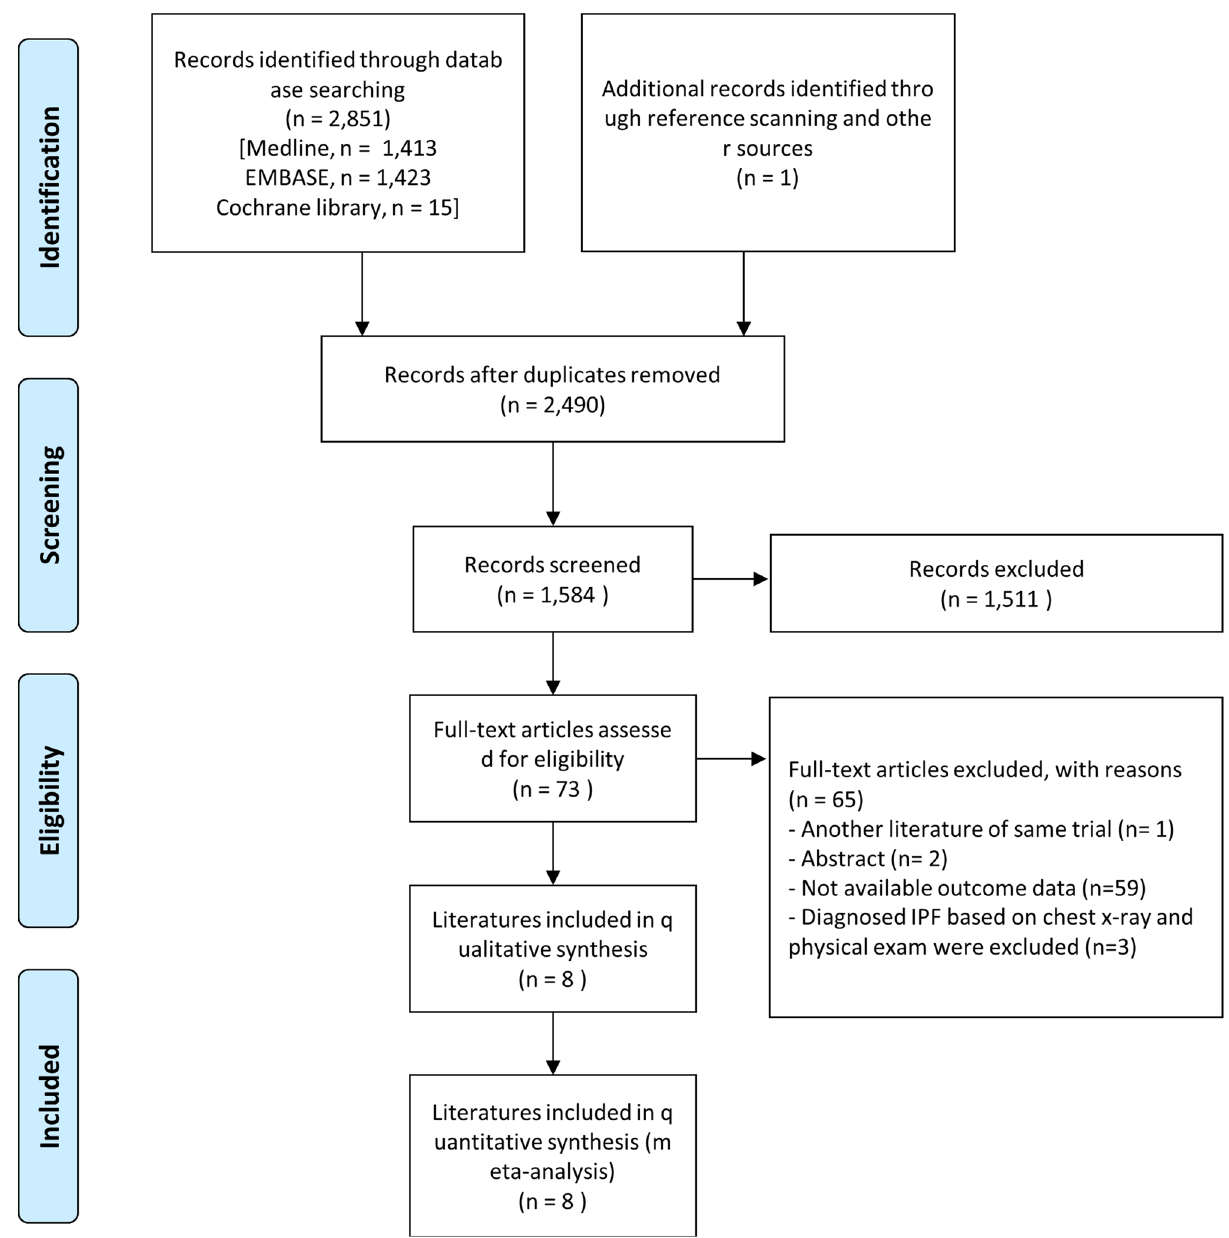
Figure 1. PRISMA (preferred reporting items for systematic reviews and meta-analyses) flow